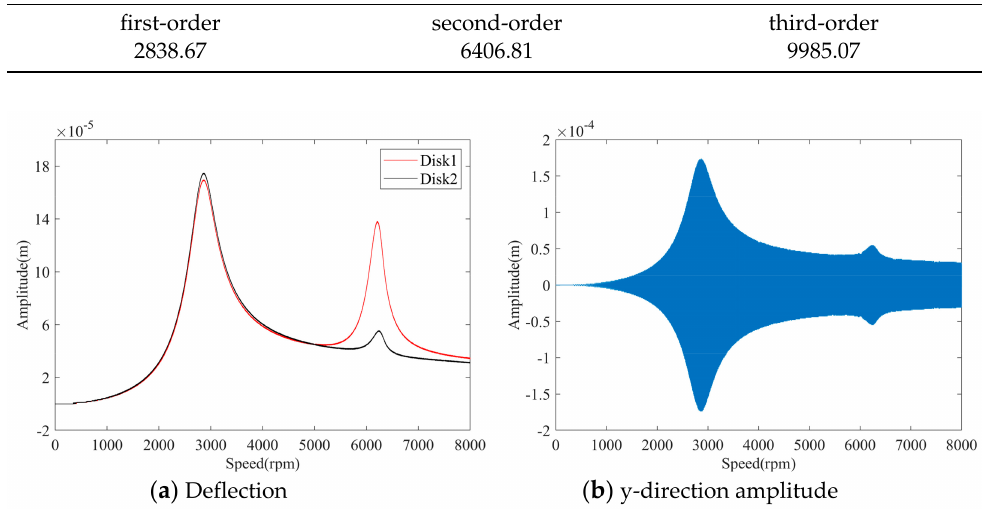
Figure 6. The deterministic response of the dual-disk